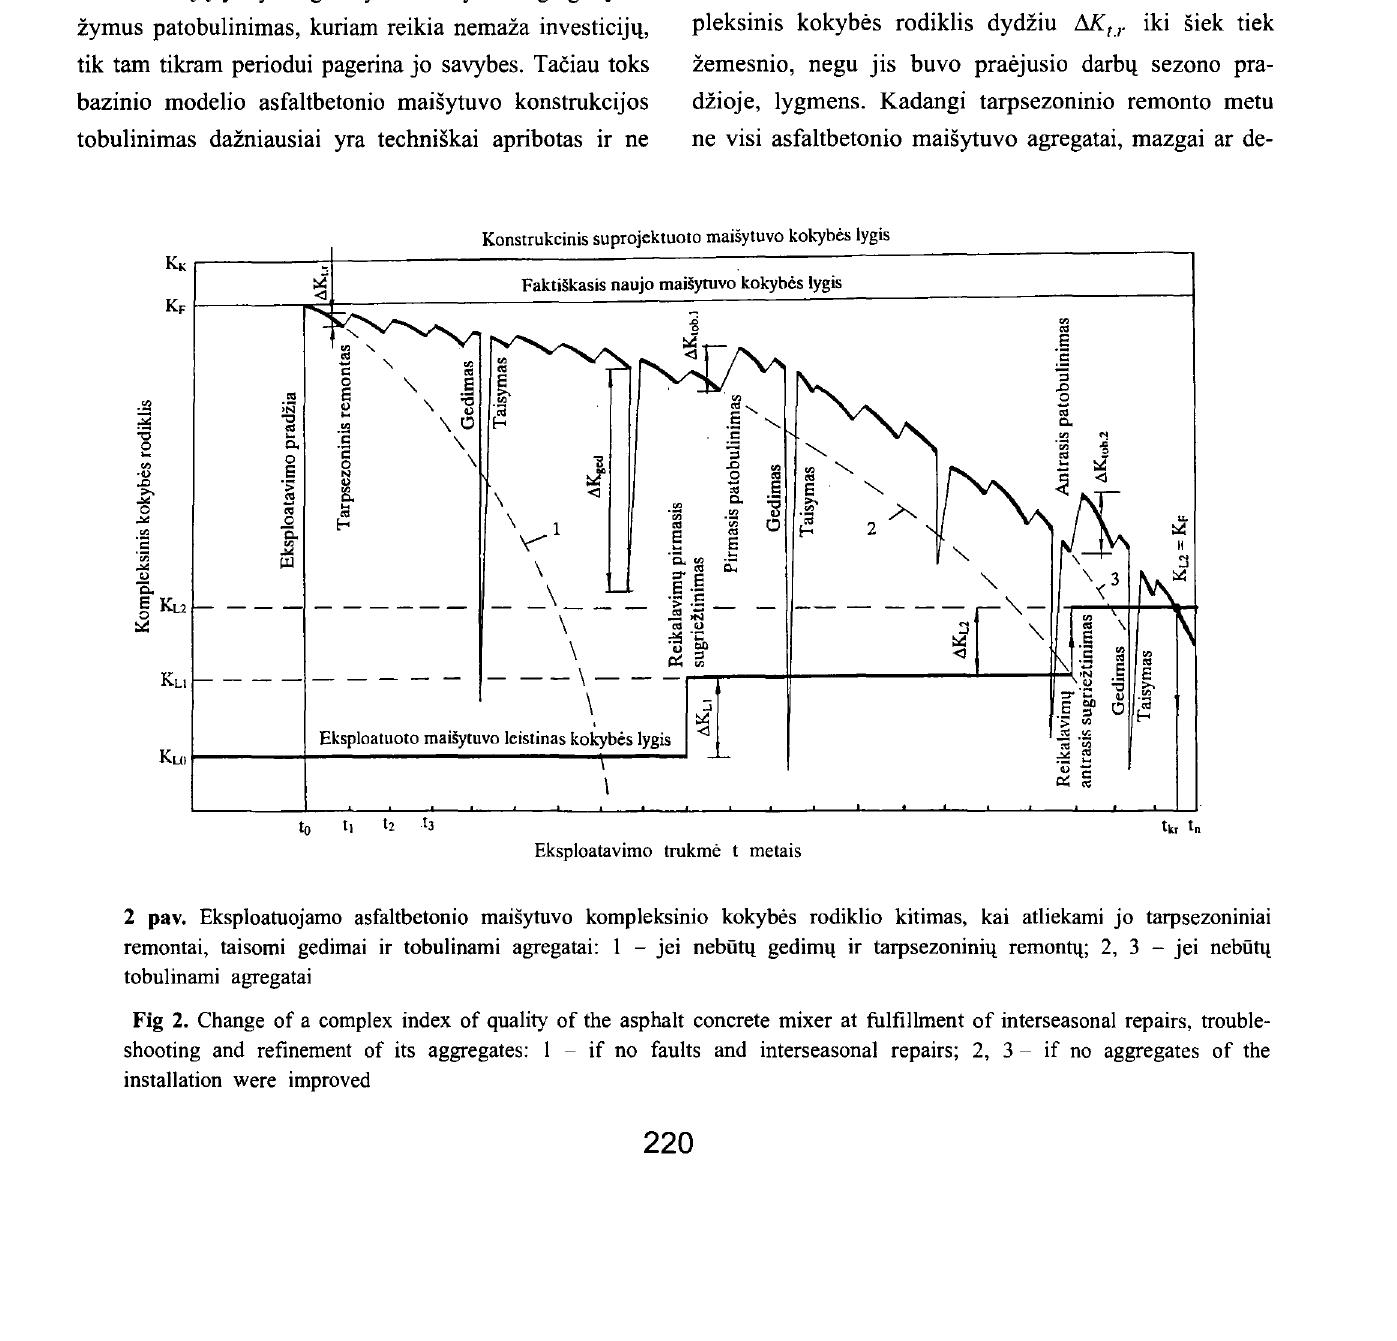
Fig 2. Change of a complex index of quality of the asphalt concrete mixer at fulfillment of interseasonal repairs, trouble shooting and refinement of its aggregates: I - if no faults and interseasonal repairs; 2, 3 - if no aggregates of the installation were